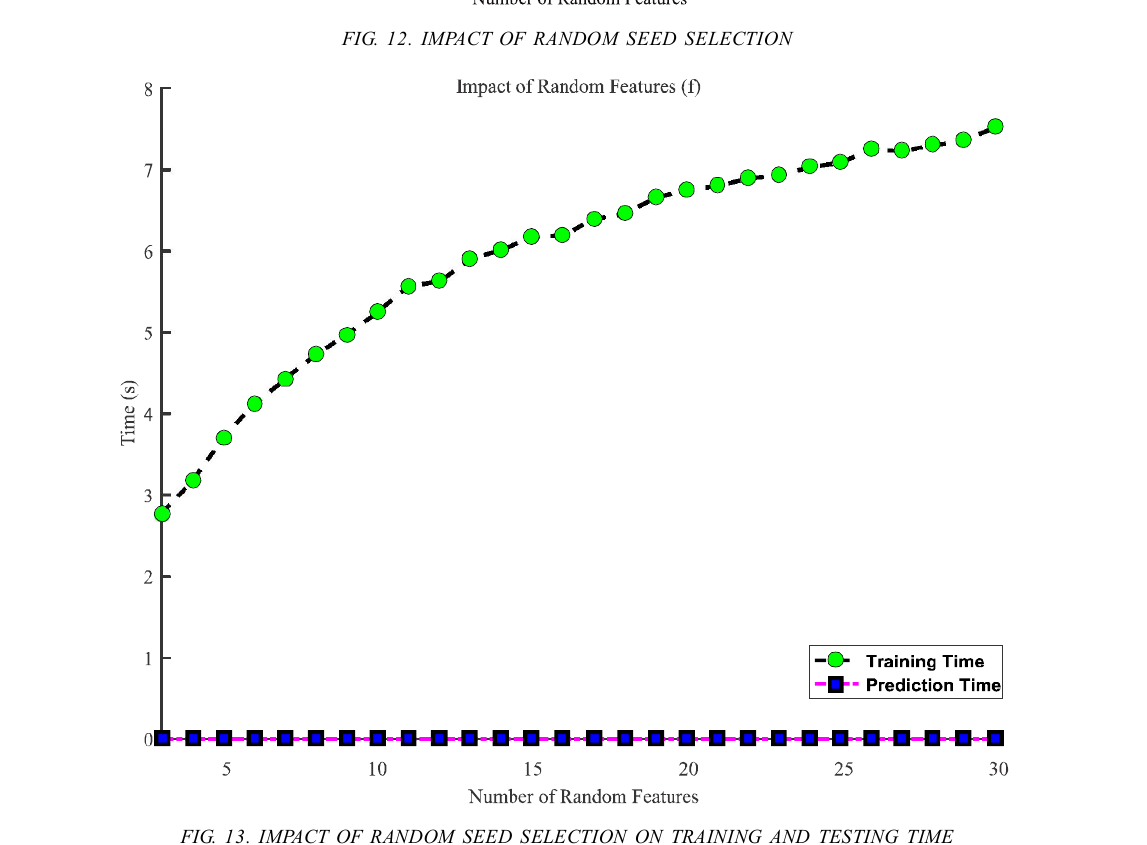
FIG. 13. IMPACT OF RANDOM SEED SELECTION ON TRAINING AND TESTING TIME